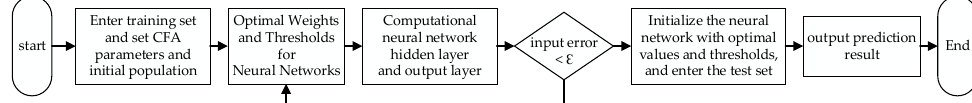
Figure 5. Flowchart of the prediction model.